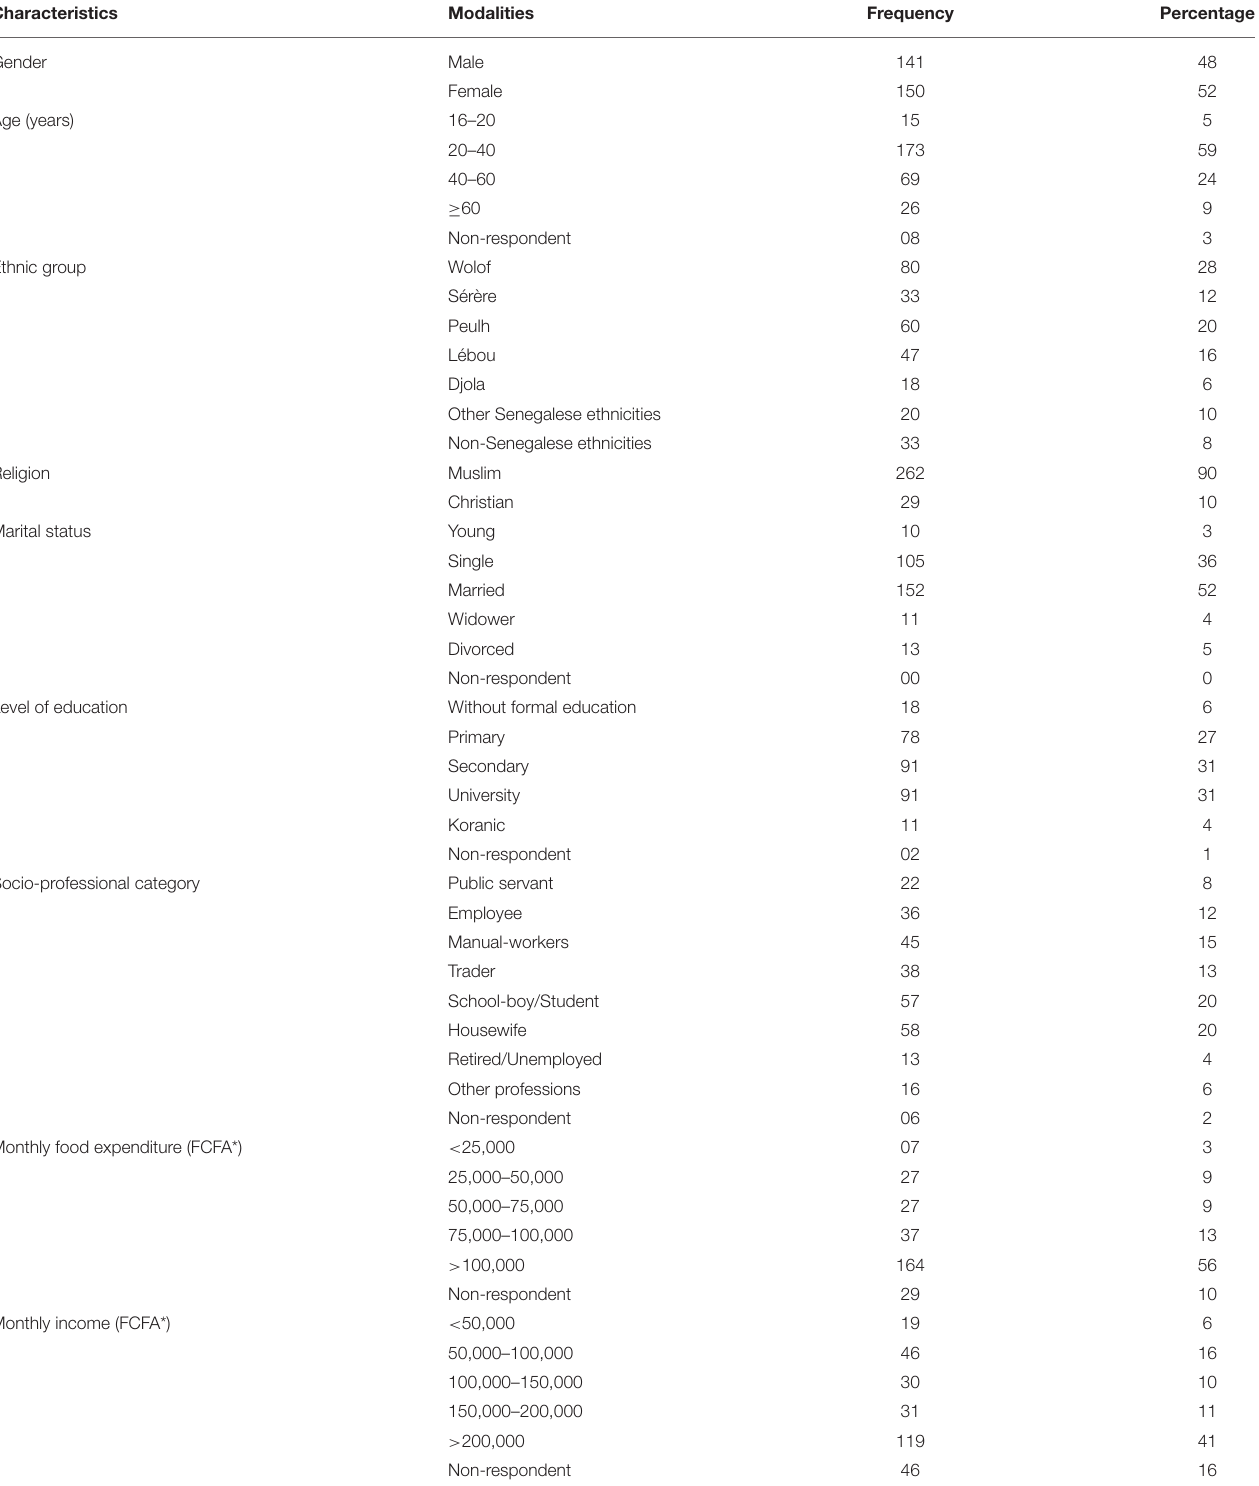
TABLE 1 | Socio-economic and demographic profile of consumers of dibiterie meat in households of the Dakar region ( n = 291).